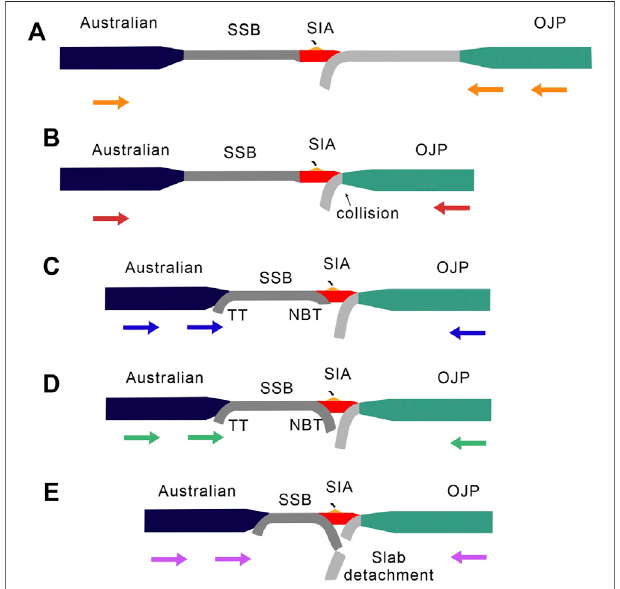
FIGURE 9 | Schematic diagram for the evolution of the New Guinea region as a sequence of stages for important events. Panel (A – E) represent different stages of evolution. The arrows represent the direction of plate